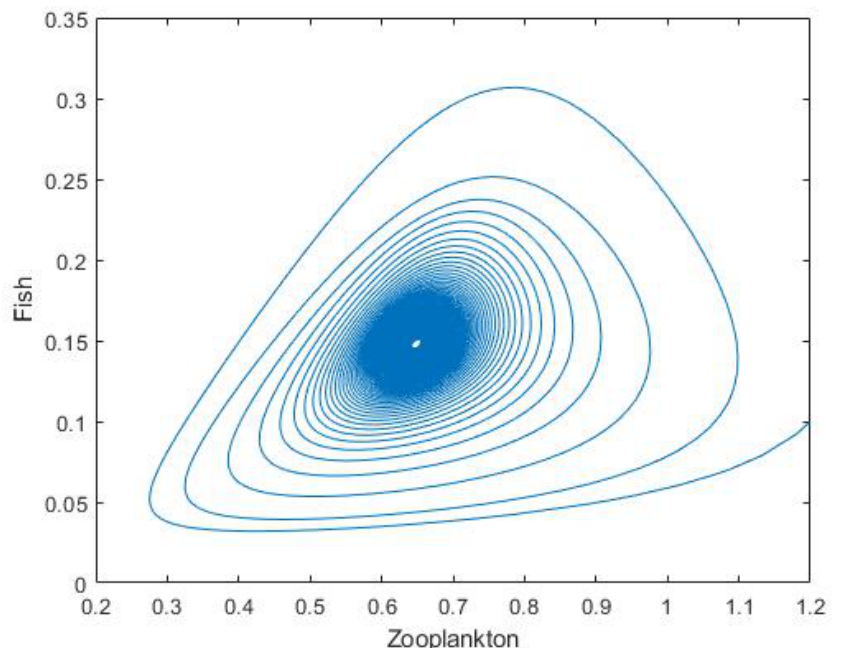
Figure 27. Equilibrium between the zooplankton and fish populations loses its stability for τ = τ +